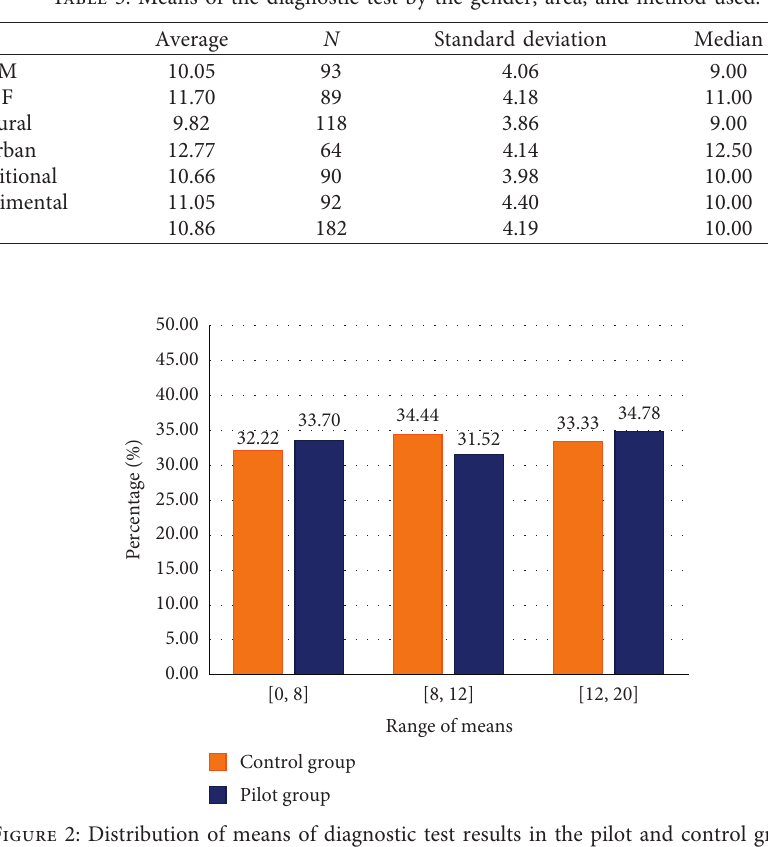
Table 5: Means of the diagnostic test by the gender, area, and method used.